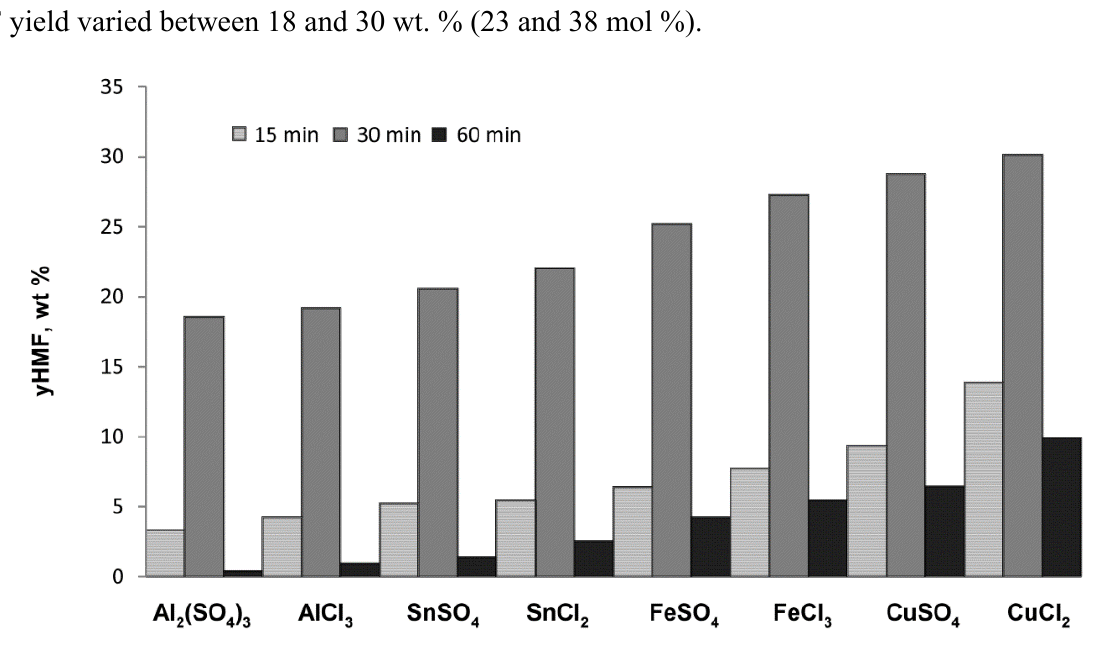
Figure 2. HMF yield as a function of the homogeneous metal salt catalyst (170 °C, 0.1 g/mL inulin, salt concentration of 5 mM, 1